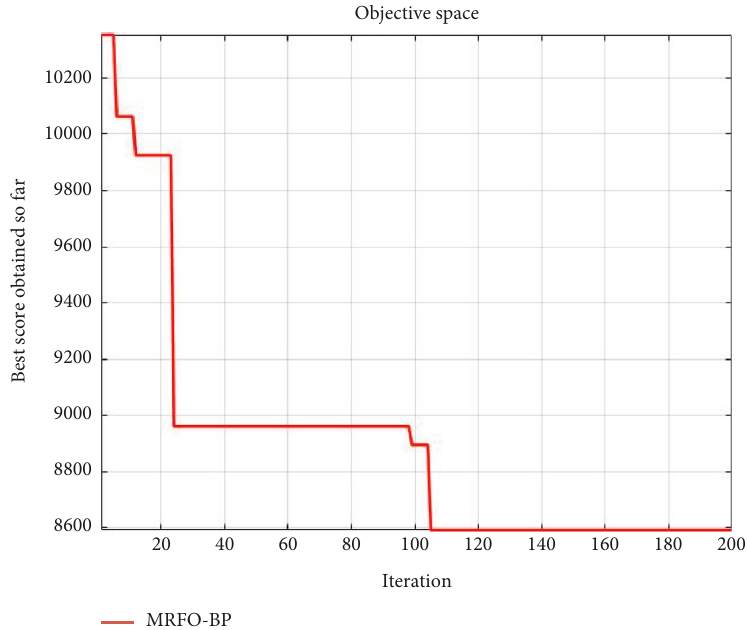
Figure 20: Historical optimal position curve of the inlet (comparative